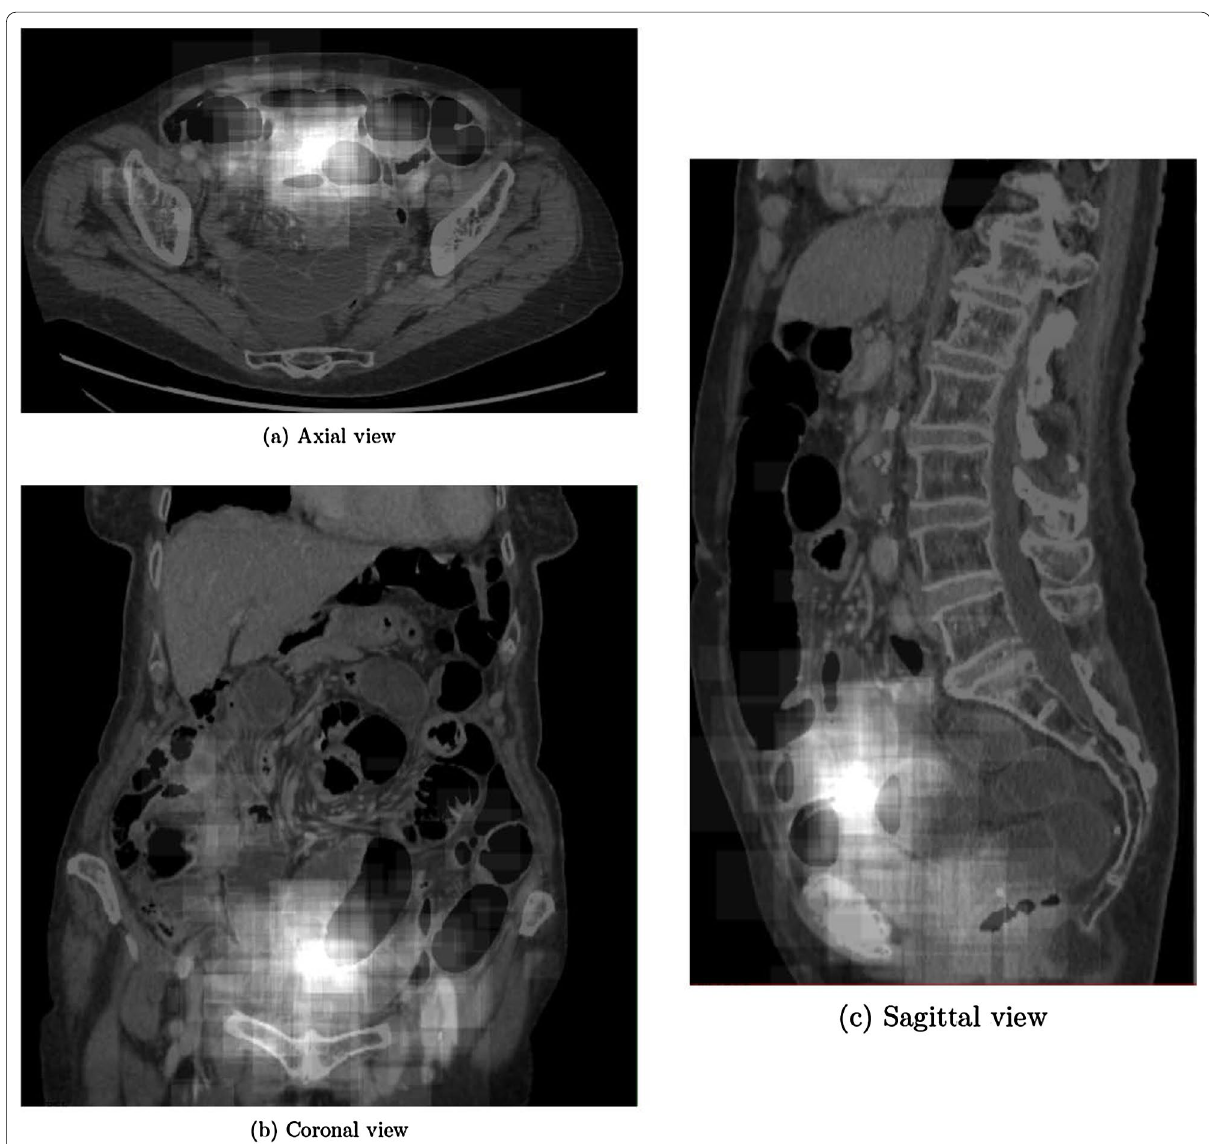
Fig. 3 Heatmap of adhesion‑related small bowel obstruction transition zone (TZ) localization. The images are shown with grey scale, with a maximum of 56.9% in white, to show the probability of presence of a TZ in any given reference volume